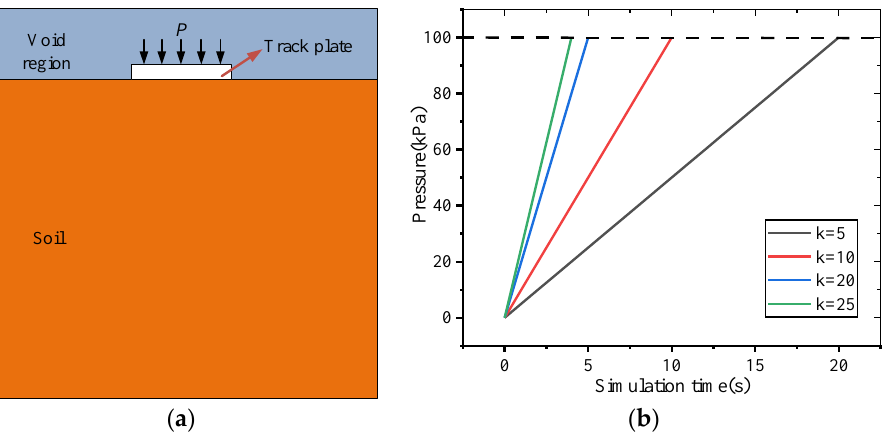
Figure 11. ( a ) Schematic diagram of numerical simulation and ( b ) the curve of pressure loading with time.